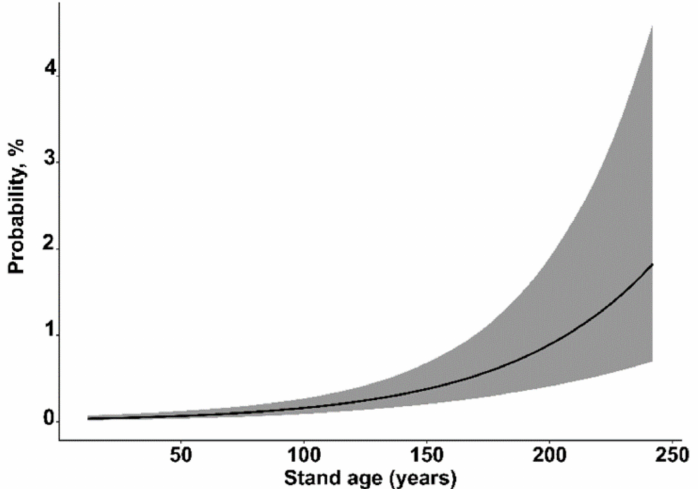
Figure 1. The influence of stand age on the probability of wind damage. The grey area represents the ± 95% credibility interval